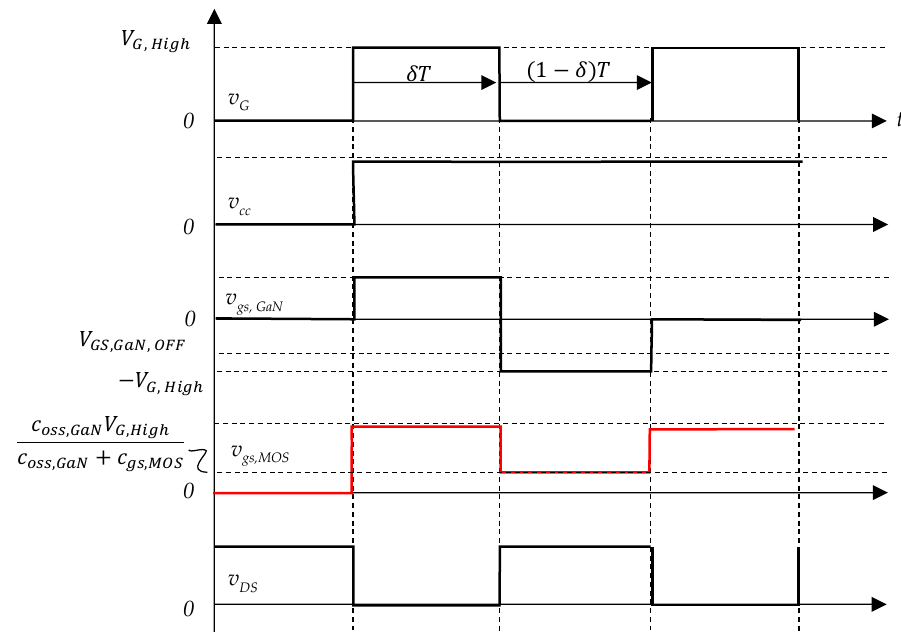
Figure 10. Alternative GaN-Switching Cascode GaN HEMT Power Module